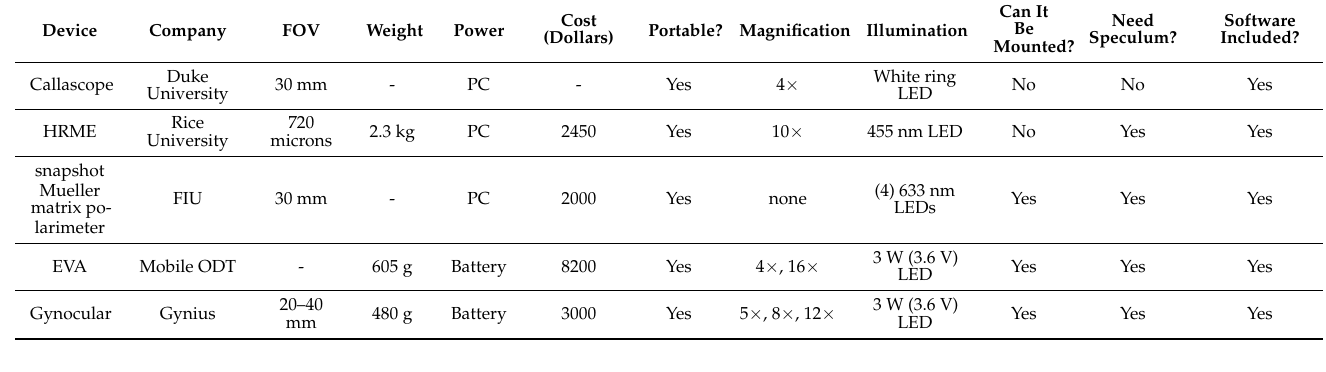
Table 2. Summary of the portable devices introduced for cervical imaging.